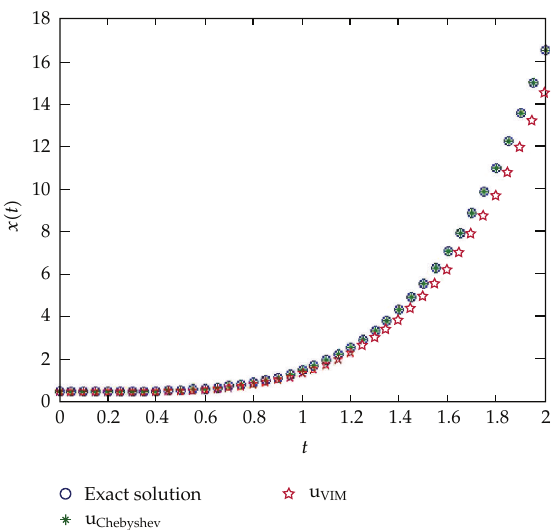
Figure 2: The behavior of the numerical solution (cid:3) at α (cid:8) 1 ,ρ (cid:8) 0 . 5 (cid:4) using ChebM with (cid:3) m (cid:8) 6 (cid:4) and VIM at r 1 (cid:8) 0 . 7, r 2 (cid:8) 0 . 7.